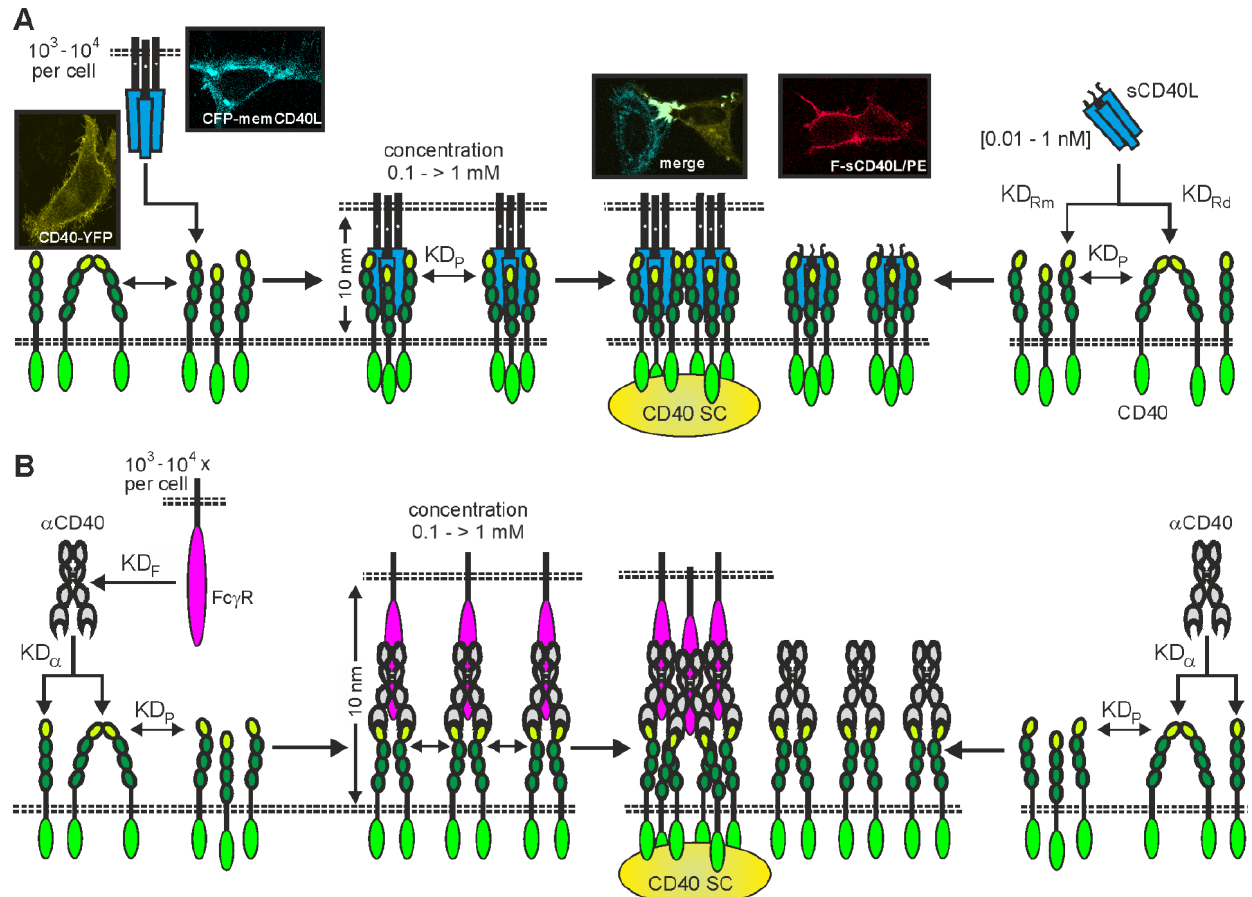
Figure 2. Two-step model of CD40 activation by CD40L ( A ) and anti-CD40 antibodies ( B ). In a first step, CD40L and anti-CD40 antibodies (αCD40) bind to monomeric (KD Rm or KD α ) or dimeric CD40 molecules (KD Rd or KD α ) with high affinity. The latter are formed to a small extent due to the weak autoaffinity of the CD40 pre-ligand binding assembly domain (PLAD; KD P ). However, the trimeric ( A ) and dimeric CD40 complexes ( B ) resulting from CD40L and αCD40 binding are not sufficient, for example, to activate the classic NFκB signaling pathway. The latter requires the interaction of two (or more) trimeric TRAF adapter proteins and thus CD40 complexes with six or more receptor molecules, which can form in a second step by autoaggregation of CD40L- or αCD40 -bound CD40 complexes. Due to the several powers of 10 increased local concentrations of trimeric and dimeric CD40 complexes that form in the cell – cell contact zone between CD40 + cells and membrane CD40L + ( A ) or FcγR + cells ( B ), respectively, membrane CD40L and FcγR - αCD40 complexes display a far stronger agonism than soluble CD40L and free αCD40 molecules. The micrographs shown in A illustrate the aggregation behavior of CD40, membrane CD40L, and CD40 in complex with memCD40L or soluble CD40L by help of fluorescent fusion proteins (CD40-YFP; CFP-memCD40L) or staining of Flag-tagged soluble CD40L with PE-conjugated anti-Flag antibody M2 (F-sCD40L). CD40 SC, CD40 signaling complex. Dotted lines indicate plasma membranes.